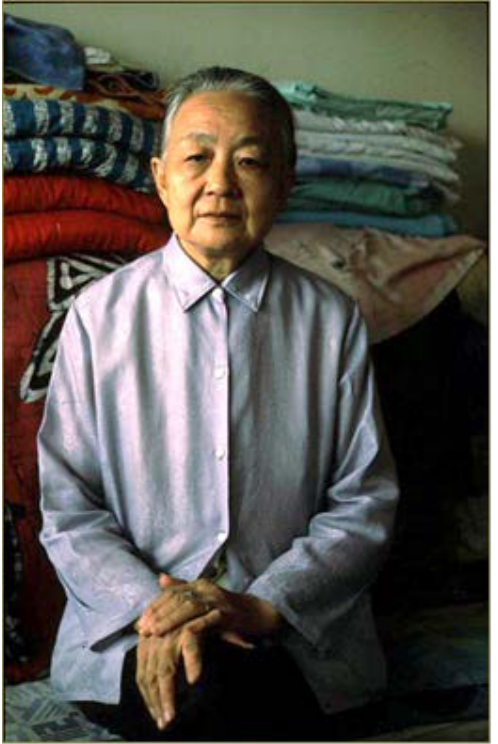
Fig 3 : Elderly Beijing Woman in early reform-era modified dress, mid-1990s, Photo: Jeanne